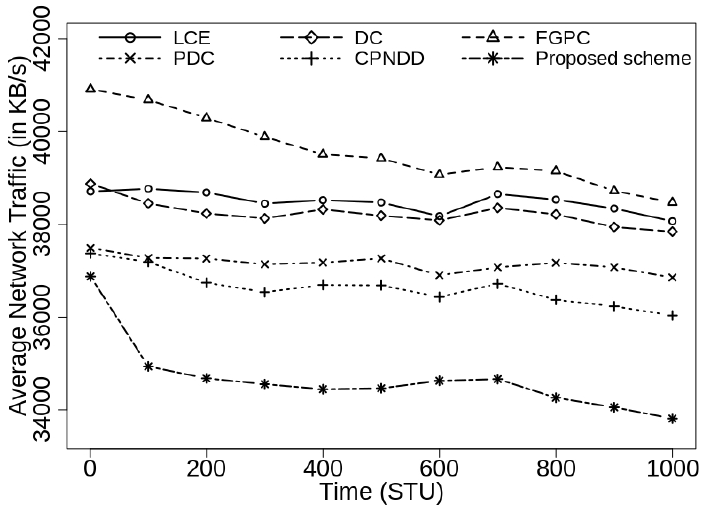
Figure 11. Comparison of average network traffic (in KB/s) with λ = 50/s, | CS ( R i ) | = 100, α = 0.7, and | Ctlg | =